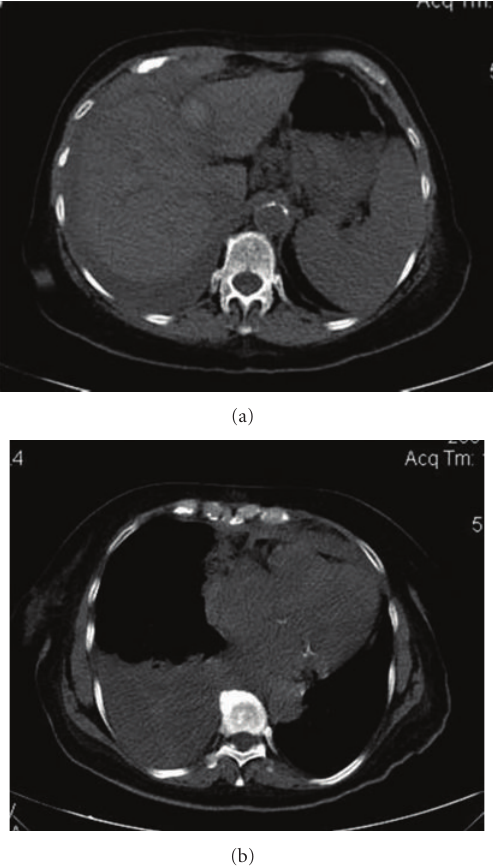
Figure 4: A chest CT was performed immediately which revealed a right pleural e ff usion with a distinct fluid